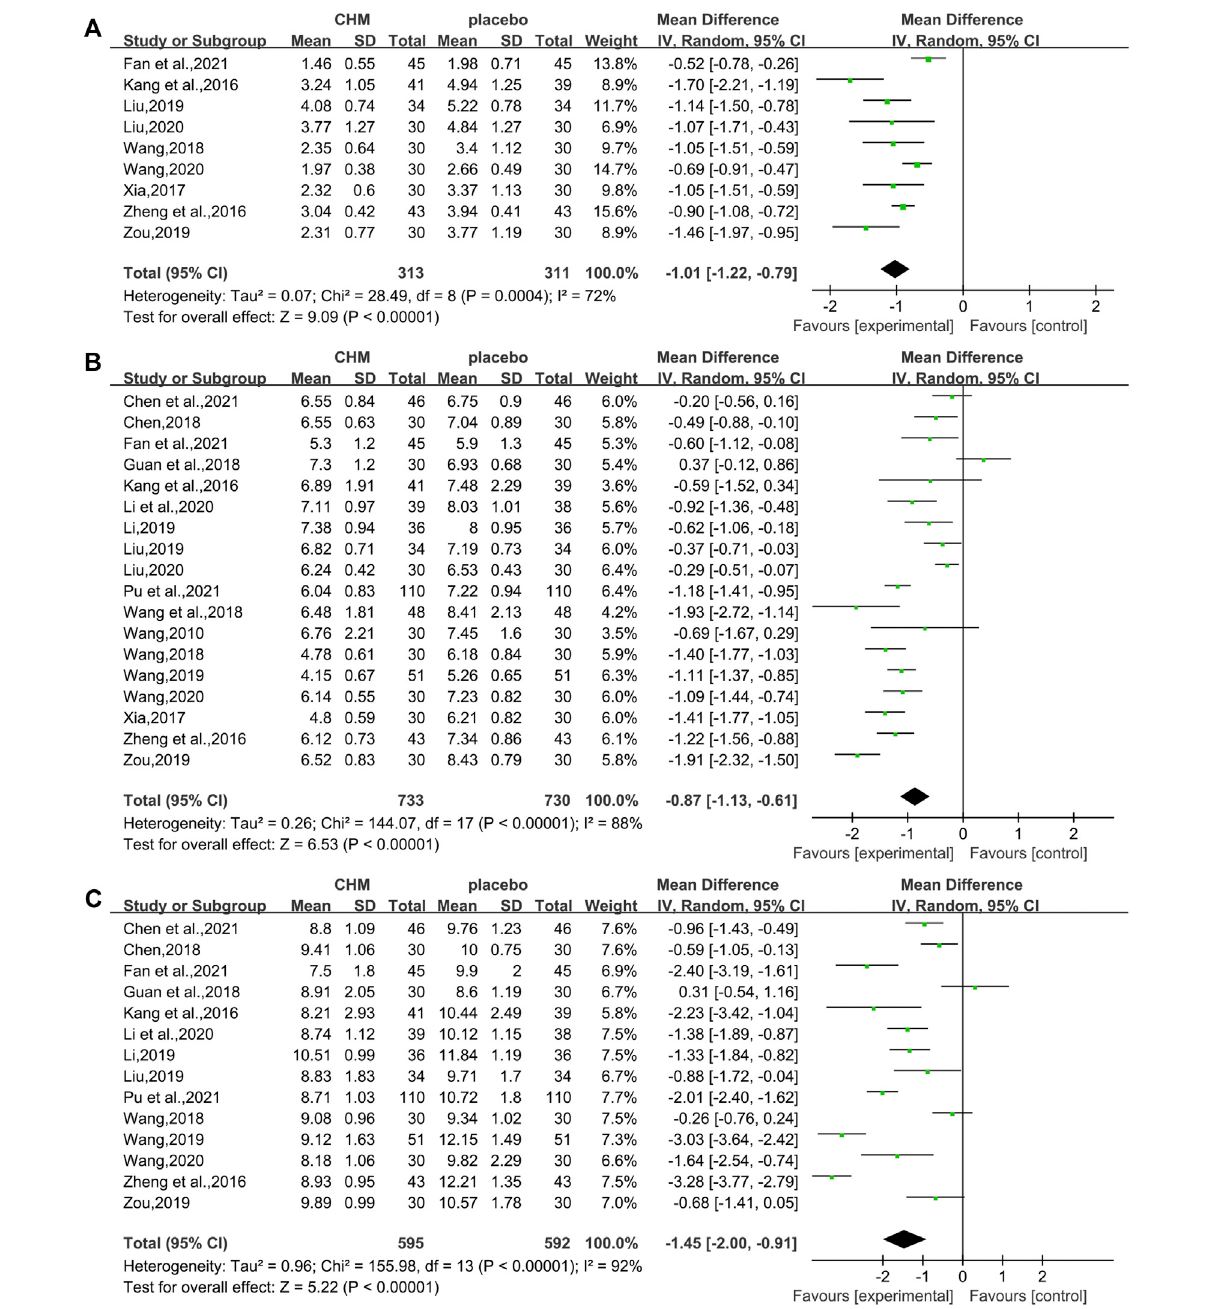
Frontiers in Pharmacology |